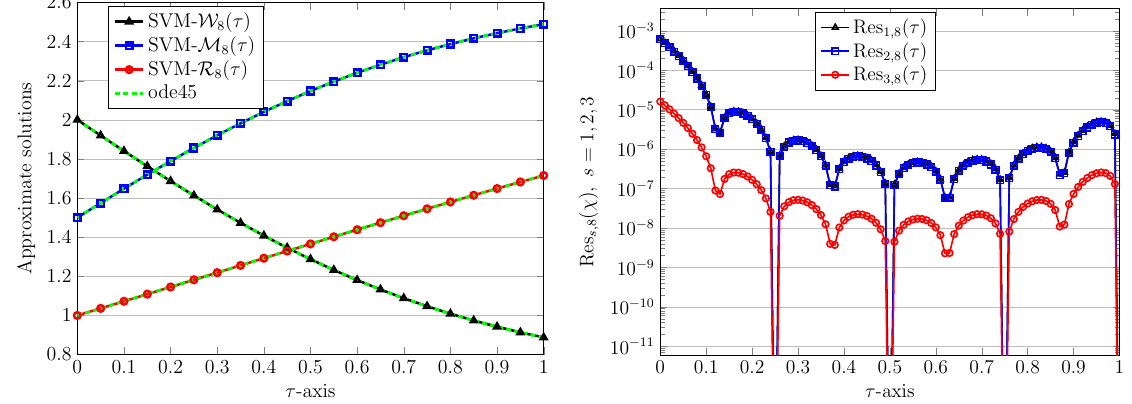
Figure 4. Graphics of numerical solutions obtained via SMV technique ( left ) and related REFs ( right ) in Test Case 2 with Q =